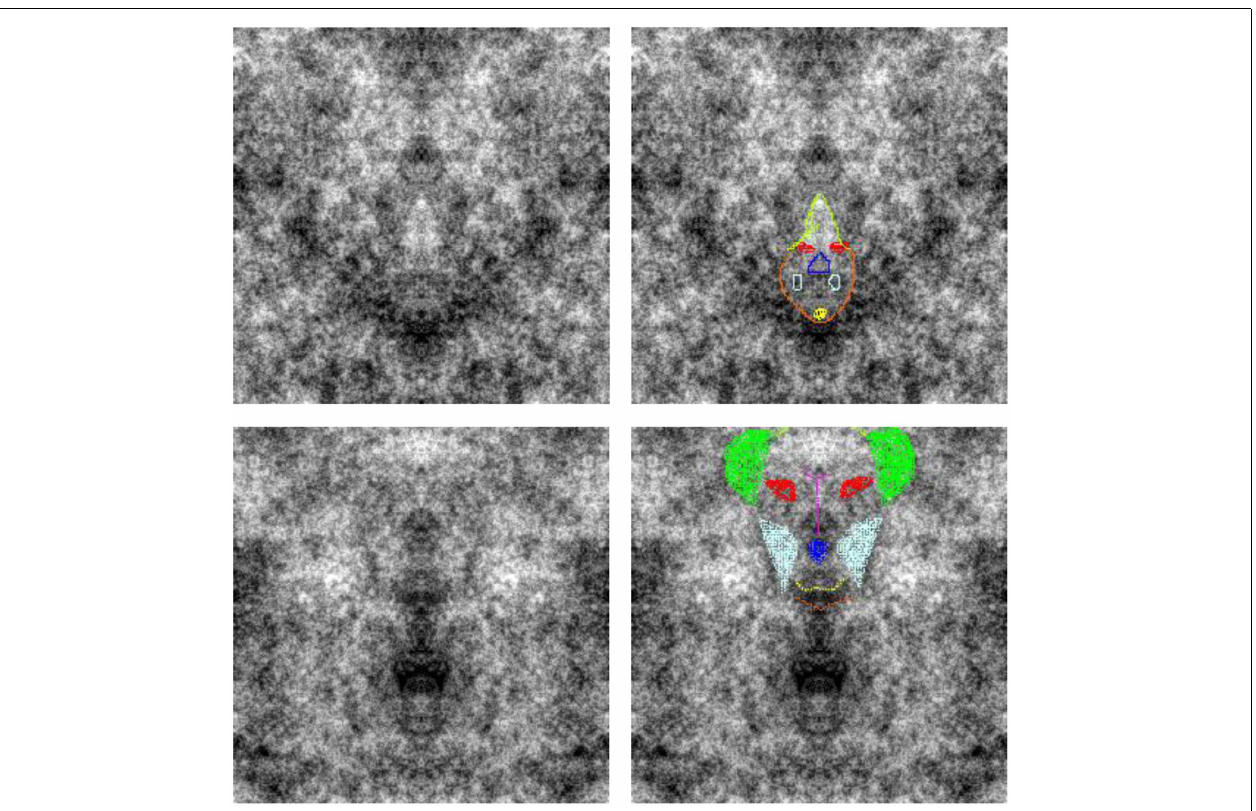
FIGURE 2 | Examples of the faces reported by observers. After identifying and describing the face, observers drew on the image to indicate the perceived position and shape of features. Different features were coded with different colors (e.g., red for eyes, blue for nose, etc.) so that their dimensions could be analyzed afterward.